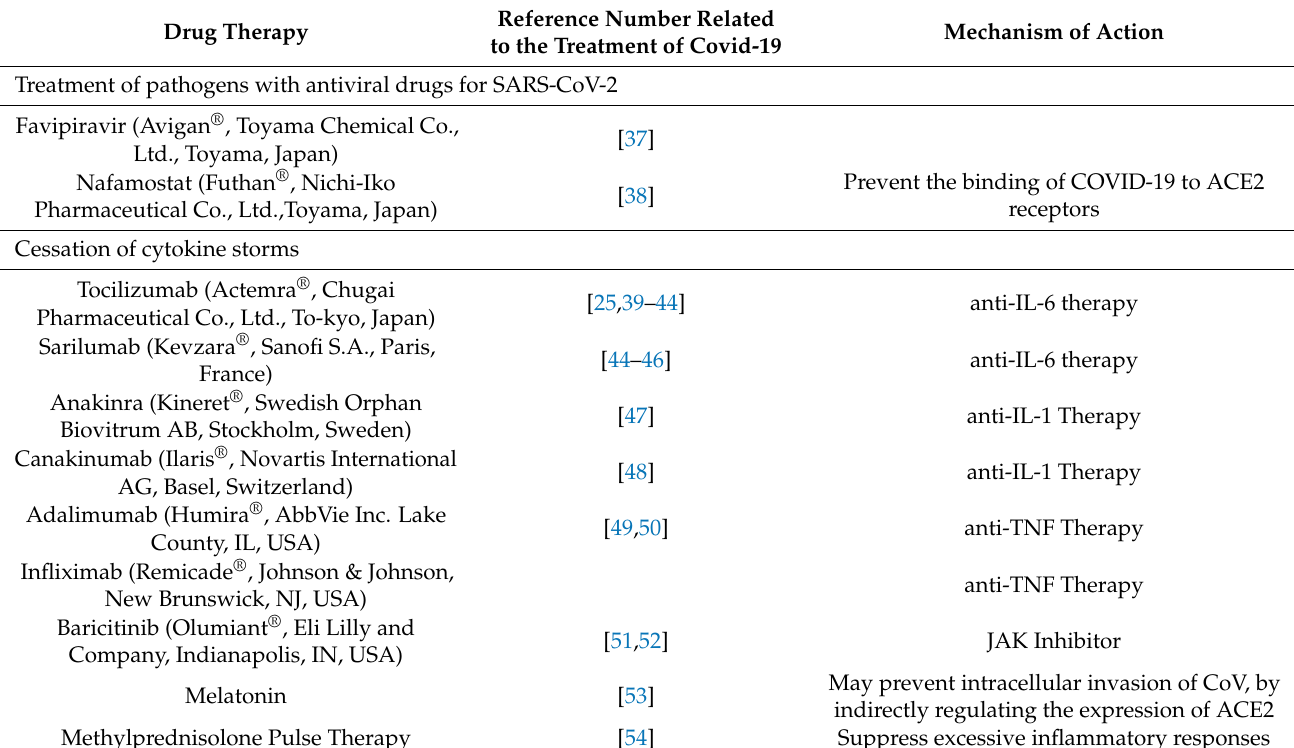
Table 1. Drug therapy for